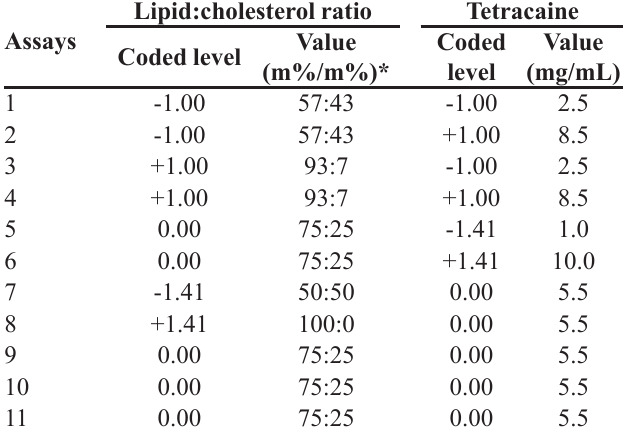
TABLE II - Coded levels and actual values of the variables concentration of lipids: cholesterol and tetracaine concentration to the experiments performed in both hydrophilic and lipophilic phases